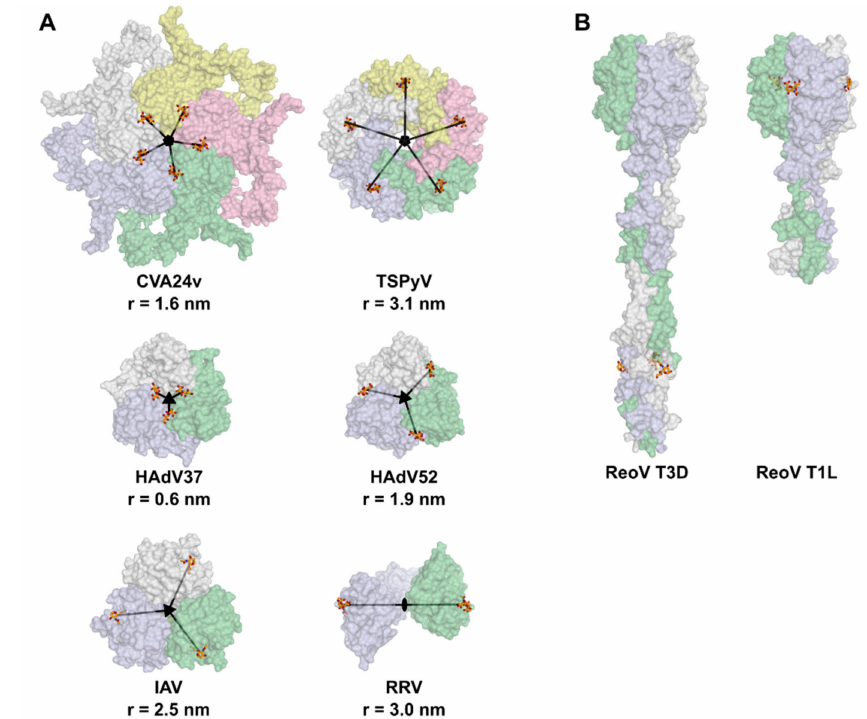
Figure 4. The symmetry relation of sialic acid binding sites in viral attachment factors. ( A ) Five-fold rotational binding site symmetry occurs in the attachment proteins of coxsackievirus A24 variant (CVA24v) and polyomaviruses, represented by the Trichodysplasia spinulosa -associated polyomavirus (TSPyV) VP1. Three-fold symmetry axes are found within the arrangement of sialic acid binding sites in human adenoviruses 37 (HAdV37) and 52 (HAdV52), as well as in the hemagglutinin of influenza-A virus (IAV). Rhesus rotavirus (RRV) lectins are dimers of a protruding VP4 domain with a two-fold sialic acid site rotational symmetry. The radii between the rotational axes and the binding sites are included. ( B ) In the human reoviruses (ReoV) of the type 3 (strain Dearing, T3D) and type 1 (strain Lang, T1L) fiber protein sigma1, the sialic acid sites display three-fold symmetry. However, their positions at the sides of the protein render them poorly useable for symmetric ligands, as exceedingly long linkers would be required to connect the sialic acid moieties. Single protomers of the attachment proteins are shown in distinct colors, respectively. PDB IDs 4q4x (coxsackievirus), 4u60 (polyomavirus), 1uxa (adenovirus 37), 6g47 (adenovirus 52), 3ubj (influenza A virus), 1kqr (rotavirus), 3s6x (reovirus T3D), and 4gu3 (reovirus